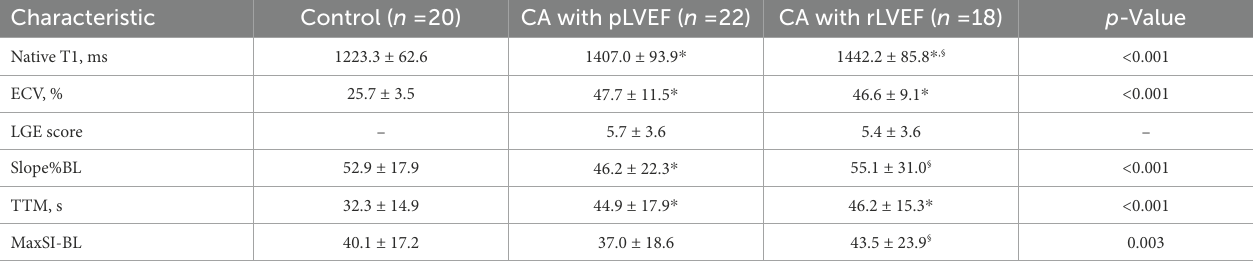
TABLE 3 Rest first-pass perfusion and tissue characteristics.